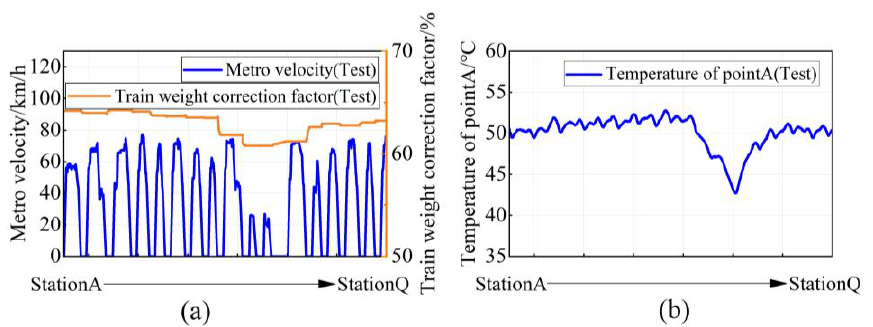
Figure 23. The heat conduction path of the chip in the module.